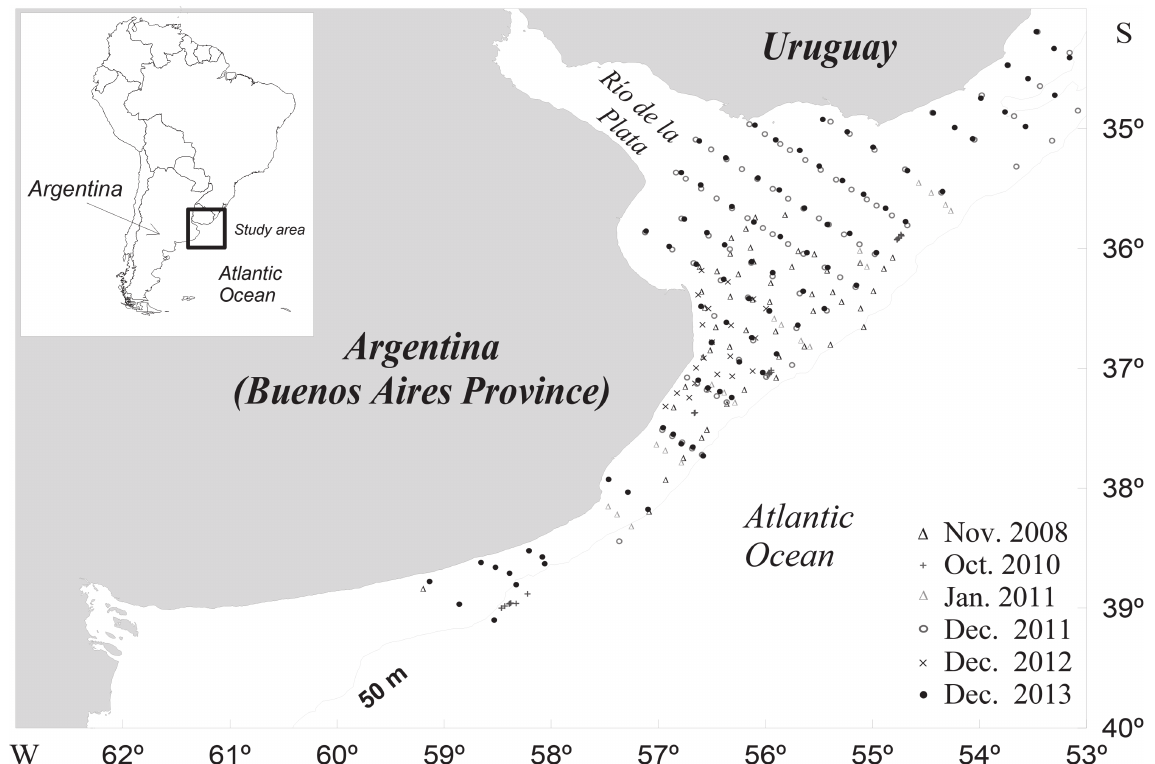
Fig. 1. Locations where Pagrus pagrus were collected during the research surveys carried out in coastal waters of Argentina and Uruguay between 2008 and